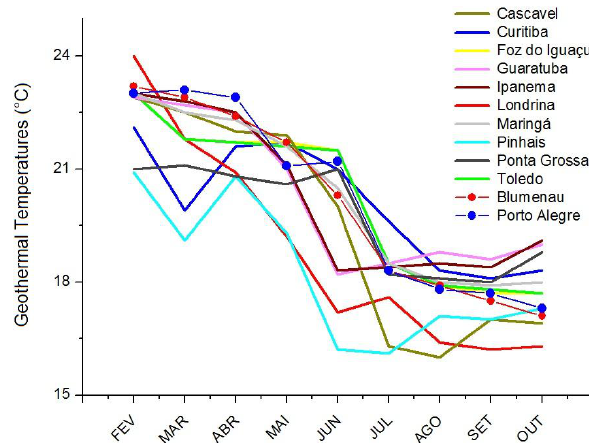
Figure 8: Geothermal temperature between February and October